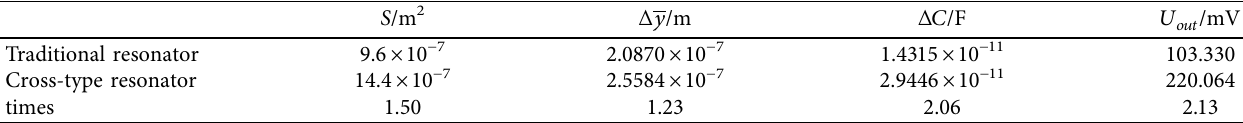
Table 1: Comparison between traditional and cross-type resonators.